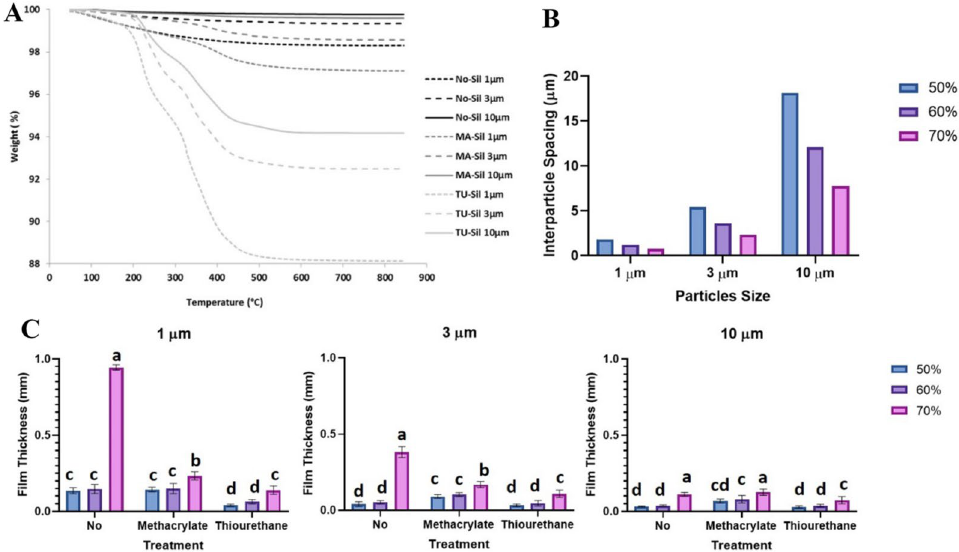
Figure 2. ( A ) Thermogravimetric curves displaying weight loss (%) as a function of temperature (°C) for each filler particle. ( B ) Interparticle spacing as a function of particle size (µm) and filler percentage by volume (vol%). ( C ) Film thickness (µm) for all tested groups. Different letters indicate statistically significant differences between the groups with the same particle size (p <